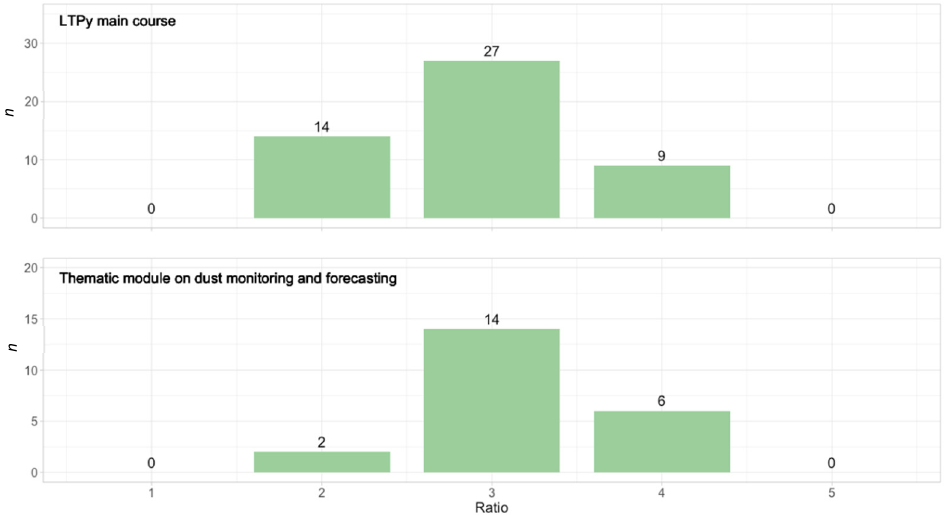
Figure 3. Frequency plot of number of notebooks per markdown/code ratio category. The ratio category describes the ratio of number of markdown cells vs. number of code cells. For example, a ratio = 3 means that the respective notebooks have three times more annotated cells than code cells. Top: frequency distribution of the notebooks that are part of the LTPy main course ( n = 50). Bottom: frequency distribution of notebooks that are part of the thematic module on dust monitoring and forecasting ( n = 22). The LTPy main course has one outlier (a notebook with mainly descriptive text on how to access different data) with a ratio of 46.5. This outlier has been removed from the plot.